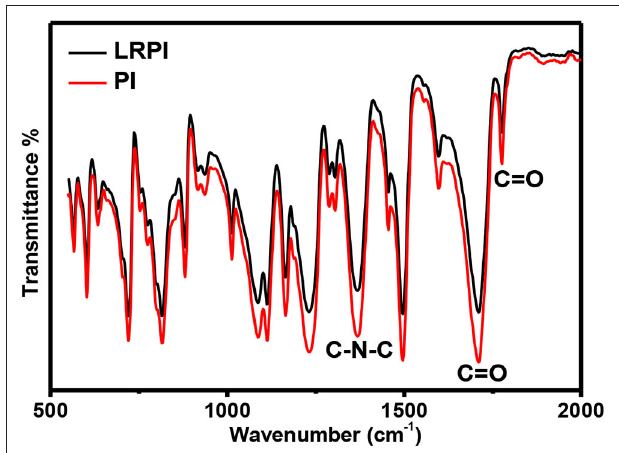
FIGURE 5 | Comparison of PI and LRPI region from FTIR spectra using pre-optimized 164 mW laser power.